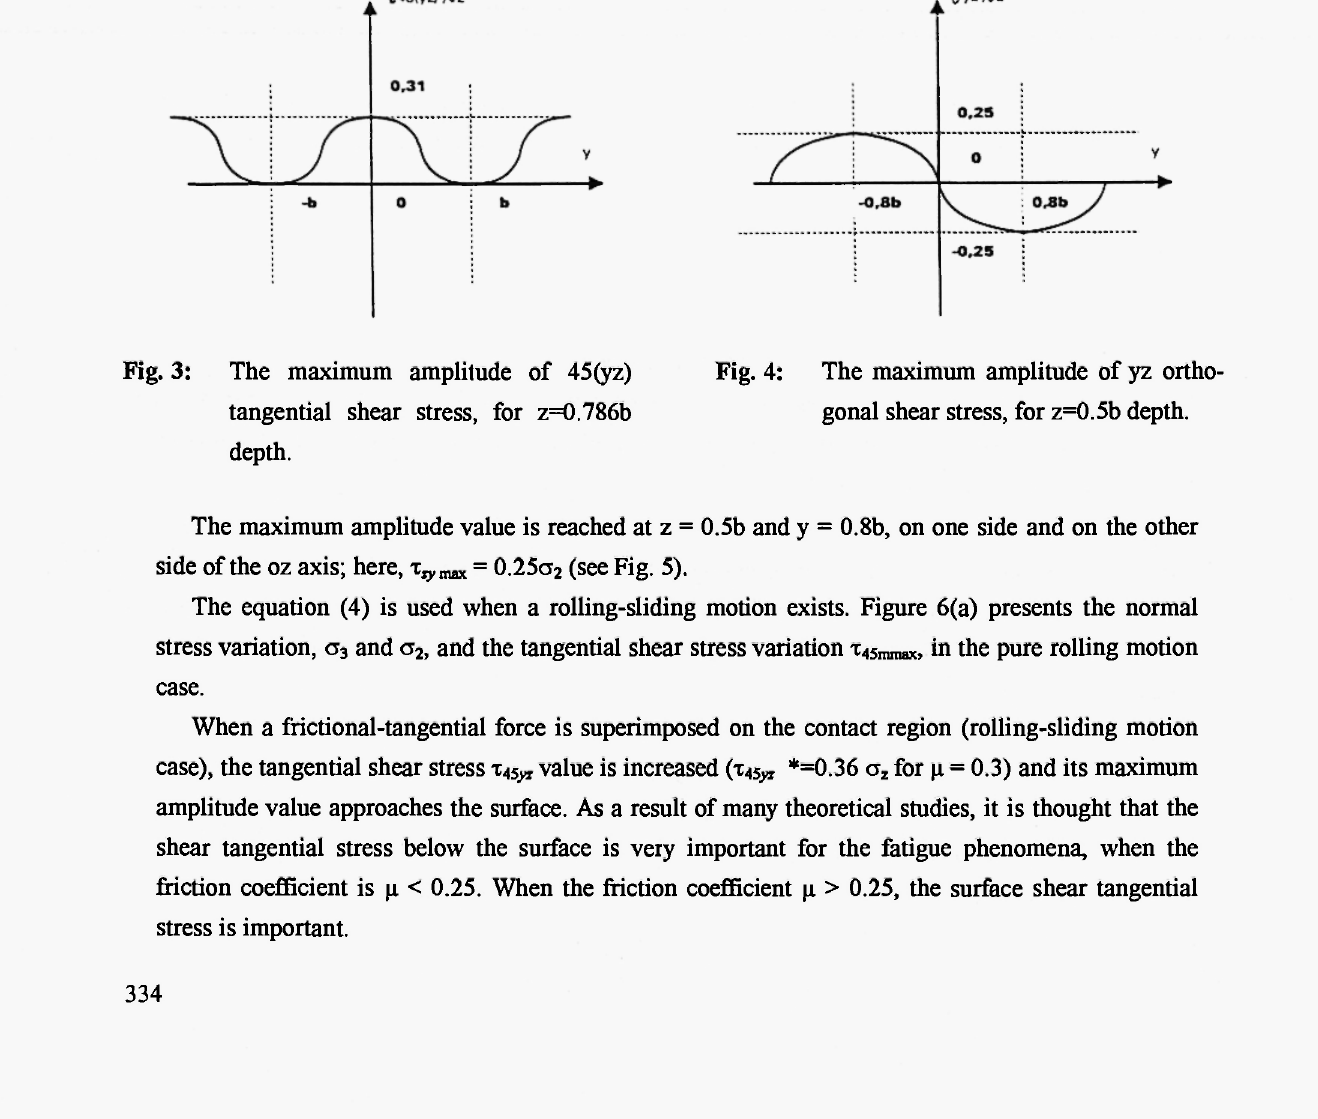
Fig. 3: The maximum amplitude of 45(yz) Fig. 4: The maximum amplitude of yz ortho- tangential shear stress, for z=0.786b gonal shear stress, for z=0.5b depth,